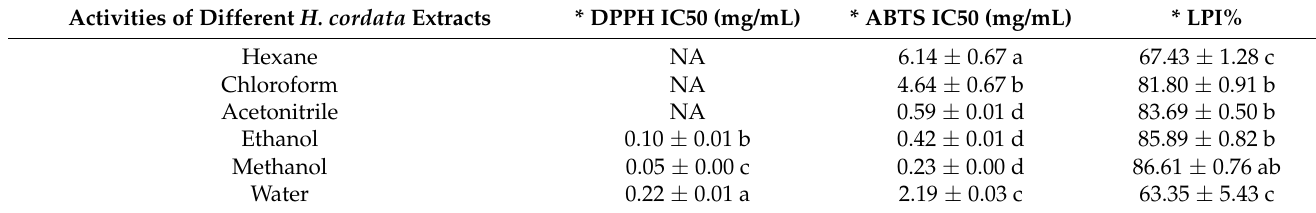
Table 3. Anti-oxidant effects of different extracts from H. cordata . Activities of Different H. cordata